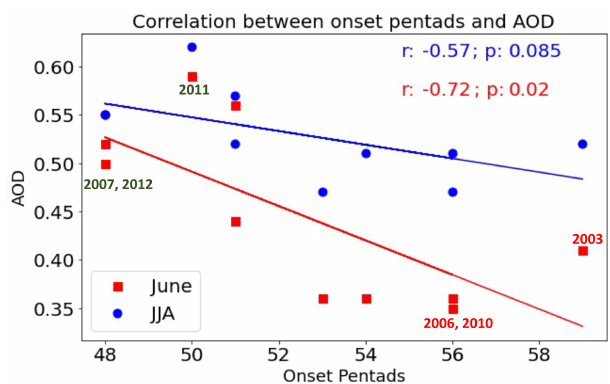
Figure 6. Correlation between the domain mean AOD between June and August and June with the onset pentads. The early- and late- onset years have also been